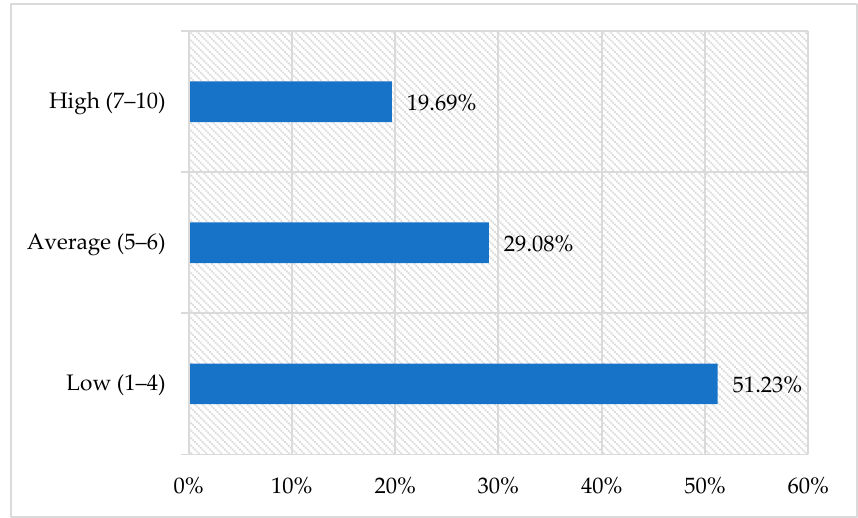
Figure 1. Positive orientation score structure among the nursing students on the sten scale.